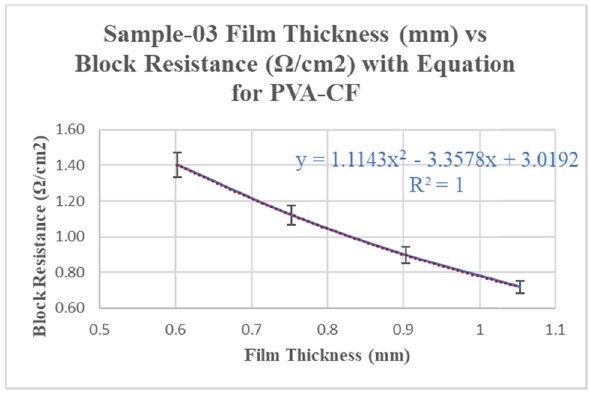
Figure 13: Sample - 03 ( CF:PVA = 0.3:30 ) block resistance ( Ω ) versus thickness ( mm ) with equation for PVA - CF. The dotted lines represent the polynomial fi tted curve and the linear fi tted curve.